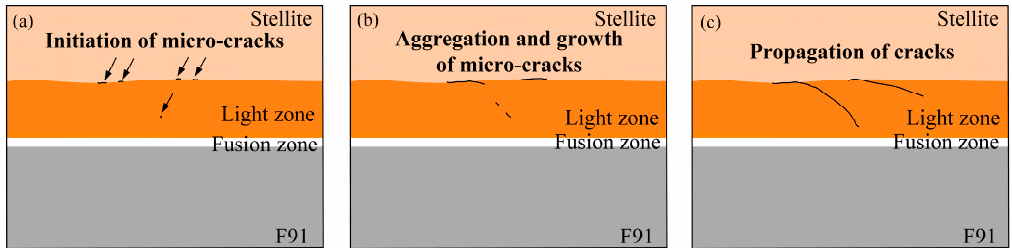
Figure 9. Schematic diagrams of initiation and propagation of cracks: ( a ) Initiation of micro-cracks; ( b ) Aggregation and growth of micro-cracks; ( c ) Propagation of cracks.